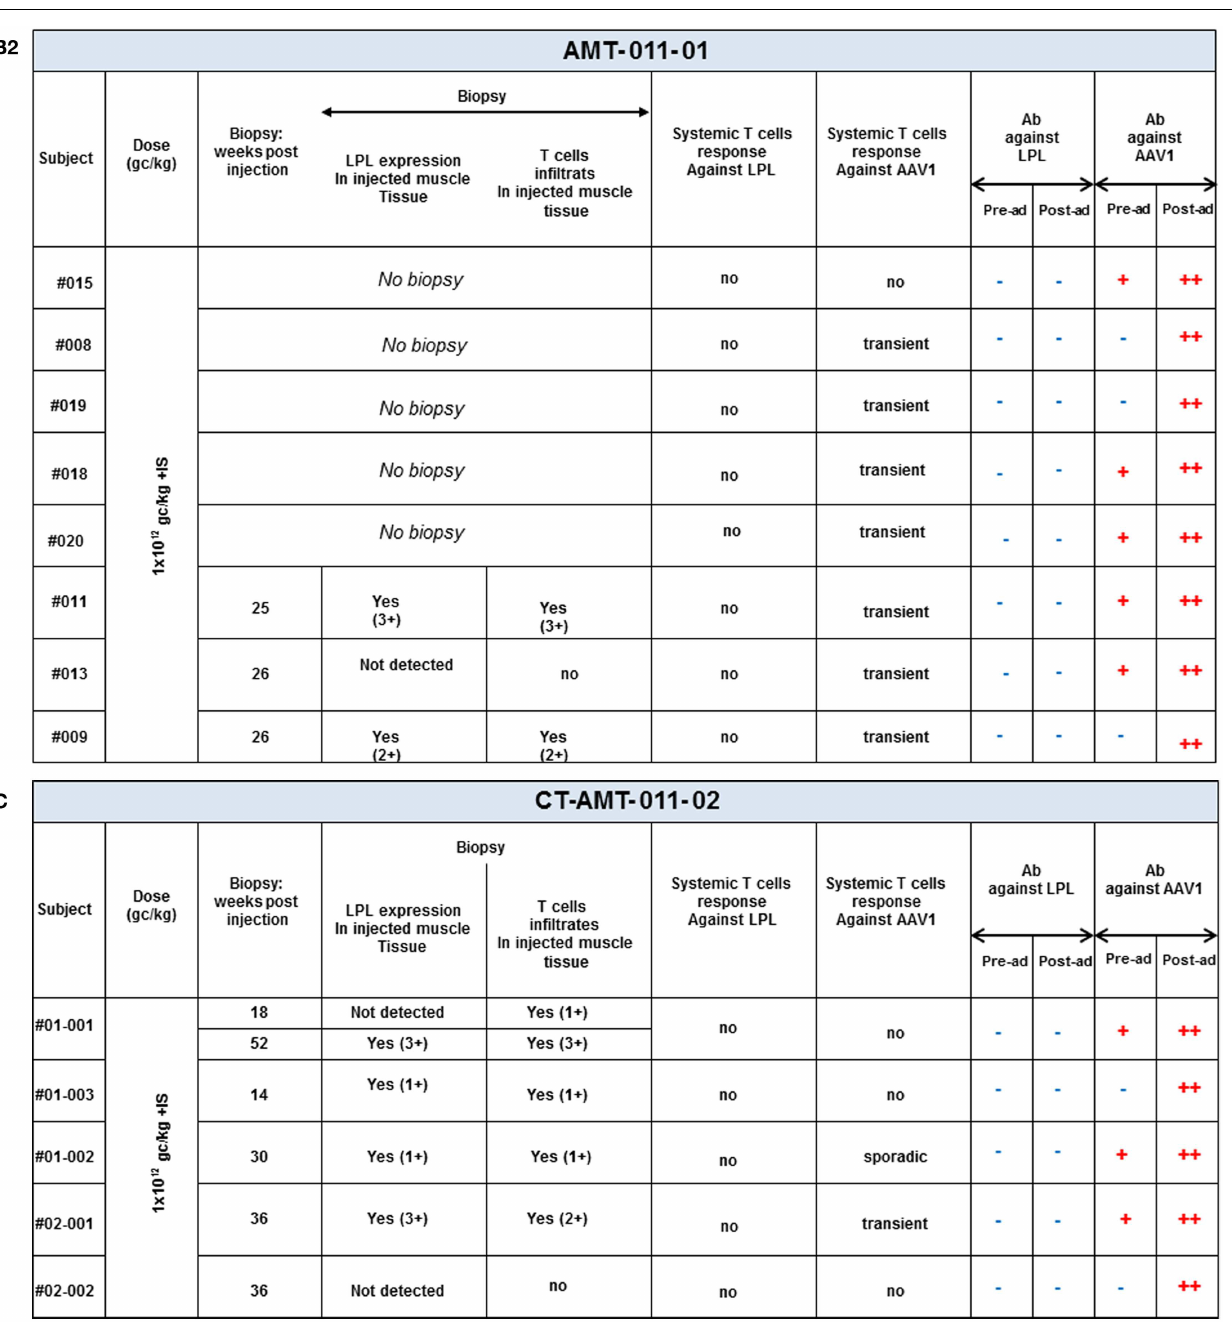
FIGURE 3 |A per-patient summary of the immunological data obtained in study CT-AMT-010 (A), CT-AMT-011-01 (B), and CT-AMT-011-02 (C) . Biopsies: the scoring of LPL-expression in injected muscle tissue reflect the number of cells positive for lipid deposits, as identified using oil red O staining of cross-sections: 0, − , 1 + , rare; 2 + , moderate; 3 + , high number.The scoring ofT-cells infiltrates in injected muscle tissue reflect the number of infiltrates observed, as identified using staining of cross-sections with cell-specific markers: 0, − , 1 + , rare; 2 + , moderate; 3 + , high number. It should be noted that the scores given are arbitrary, simply providing a semi-quantitative or relative means to distinguish between patients in terms of amount of inflammatory cells observed. As such, a score of 3 + represents the highest score observed in the study. SystemicT-cells responses: samples were said to be positive forT-cells when upon stimulation with antigen they contained